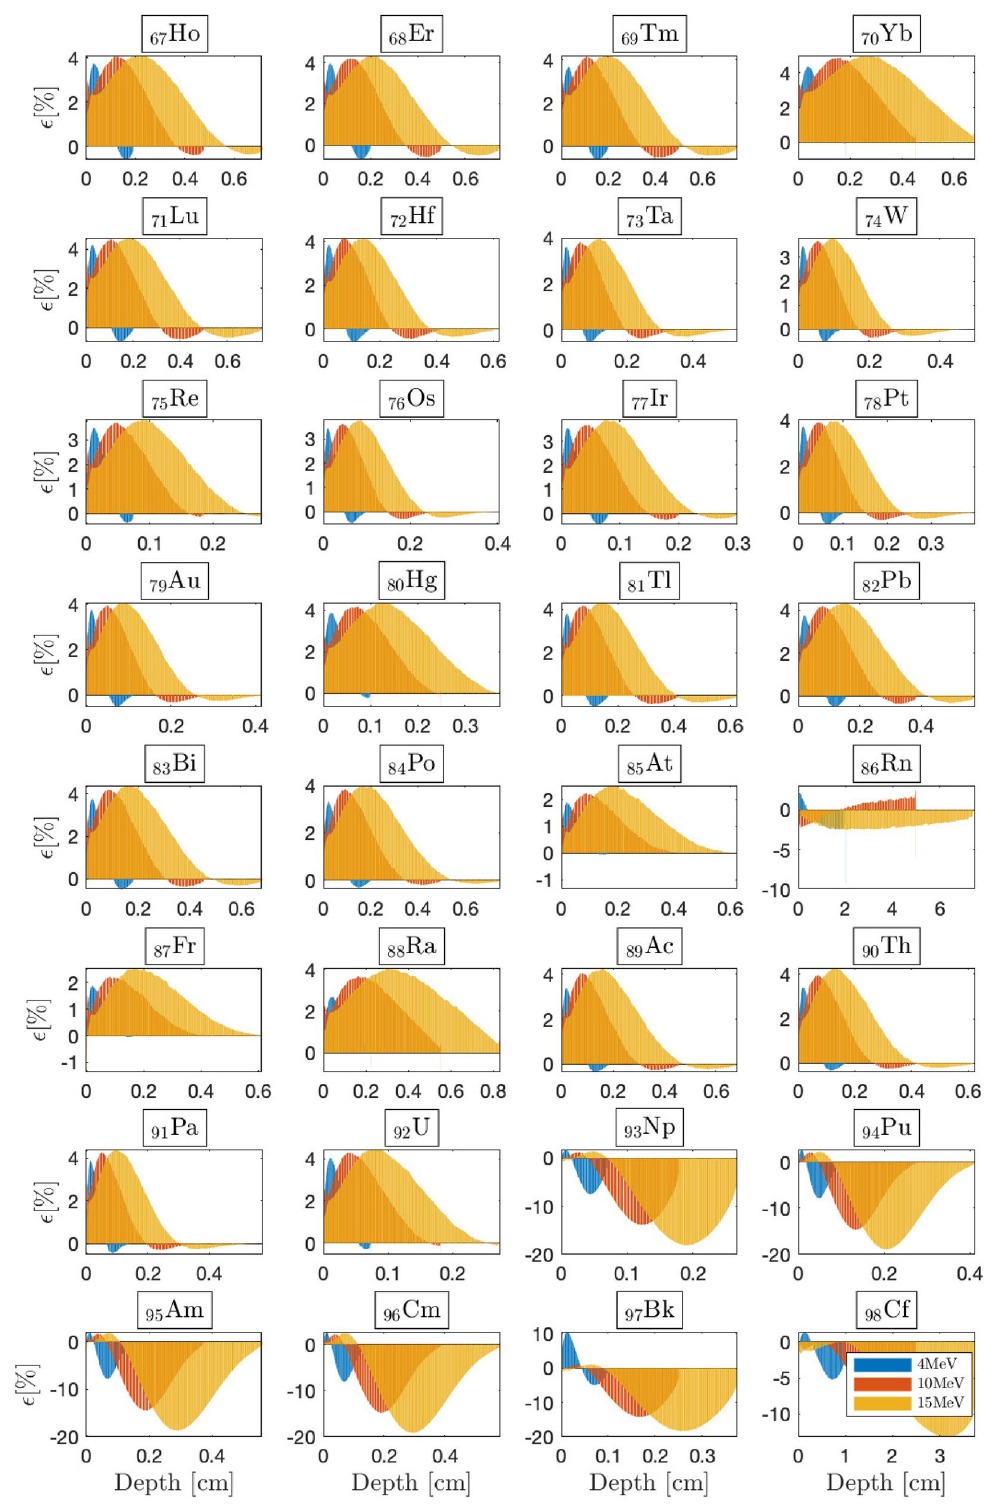
Figure 7. BFP-MC relative differences in energy deposition profiles vs. depth for selected 4, 10 and 15 MeV beams from Z = 67 to Z = 98 . The irradiated slabs’ dimensions are fixed to the beam’s range within the irradiated material. Monte Carlo convergences are obtained for a 0.2% mean standard